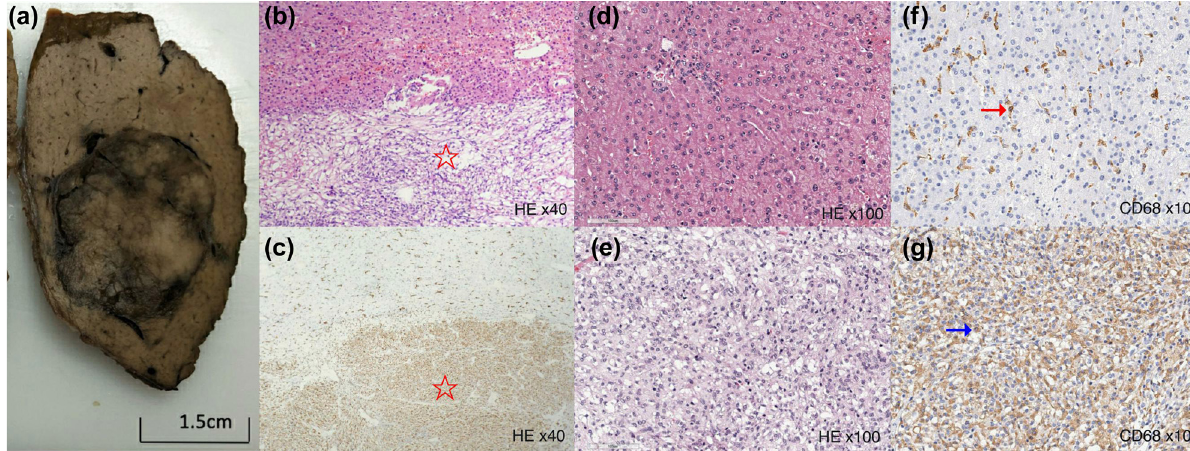
Figure 4: Pathologic and histopathologic fi ndings of a primary hepatic perivascular epithelioid cell tumor. ( a ) The gross appearance of the tumor on cut dissection shows a well - demarcated brown to gray tumor surrounded by liver tissue. ( b ) A low power photomicrograph of liver and tumor histopathology using H & E staining ( H & E staining × 40 ) . A sharp demarcation between the tumor margin and normal liver parenchyma ( star ) is observed. ( c ) A low power photomicrograph of the liver ( star ) and tumor tissue with CD68 immunohistochemical ( IHC ) staining ( H & E staining × 40 ) ; the tumor cells are strongly positive for CD68. ( d ) and ( f ) High power photomicrographs of normal liver using H & E and CD68 IHC staining, respectively ( H & E staining × 40 ) . ( f ) Kup ff er cells are strongly positive for CD68 and scattered throughout the liver tissue section ( arrow ) . ( e ) A high power photomicrograph of the tumor with H & E staining ( H & E staining × 100 ) . ( g ) A high power photomicrograph of the tumor using CD68 IHC ( H & E staining × 100 ) . CD68 positive cells are densely packed and shaped di ff erently from those of the Kup ff er cells in normal liver ( arrow )